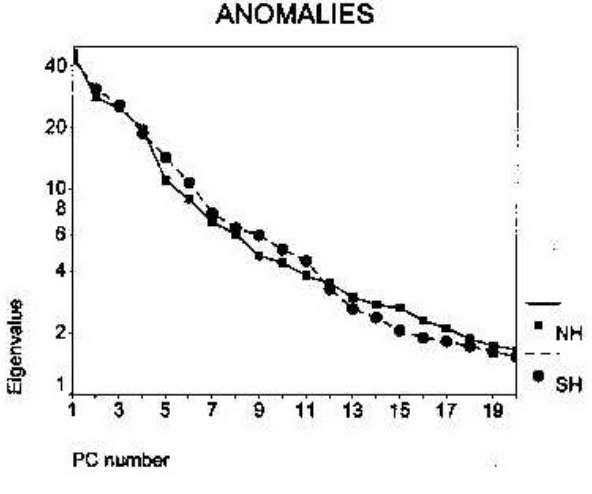
Fig. 6. As in Fig. 1 but for anomalies.